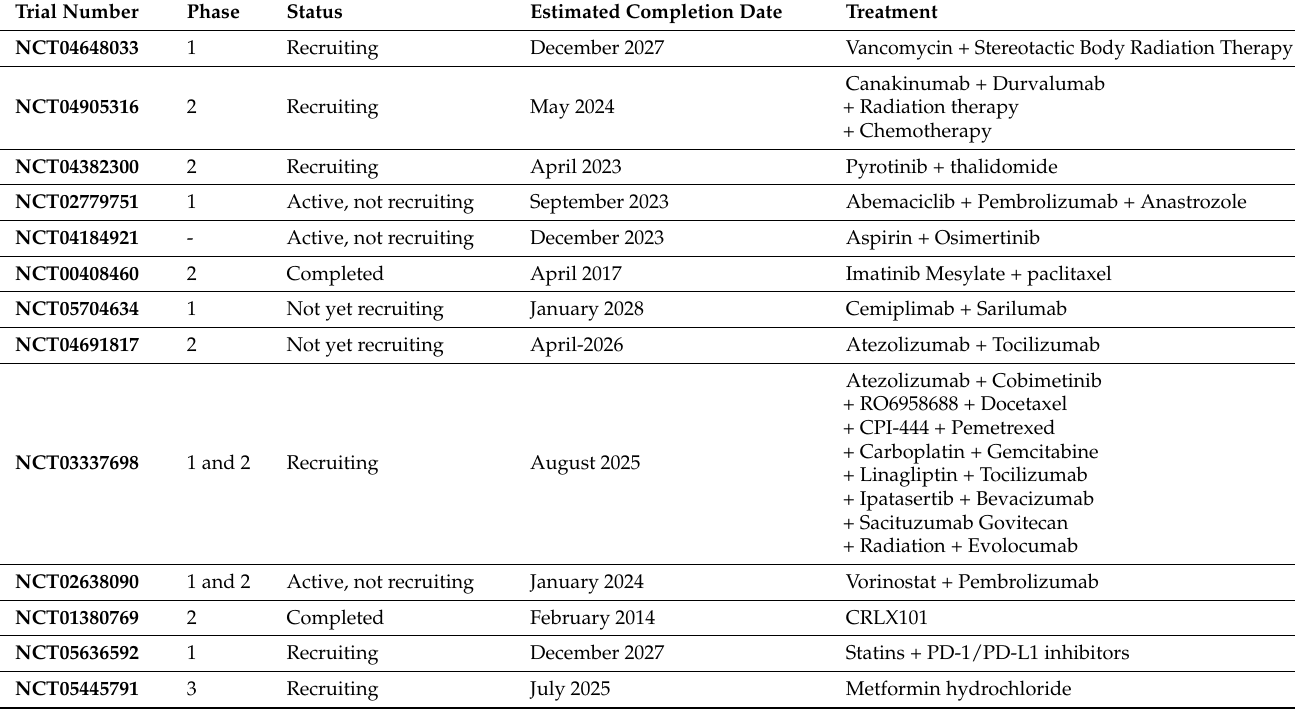
Figure 2. Chemical structures of the drug to be repurposed. Table 3. Drugs currently undergoing clinical trials for the treatment of non-small cell lung cancer.